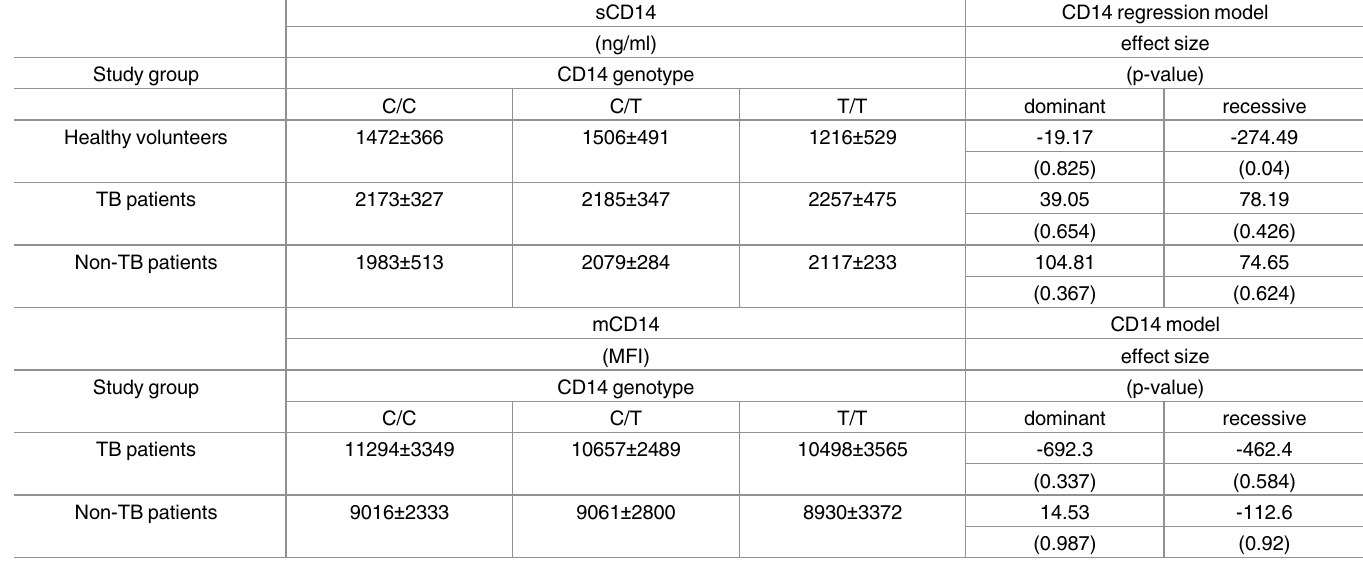
Table 8. Association analysis of sCD14 levels or mCD14 expressionwith the CD14(-159C/T) genotype using linear